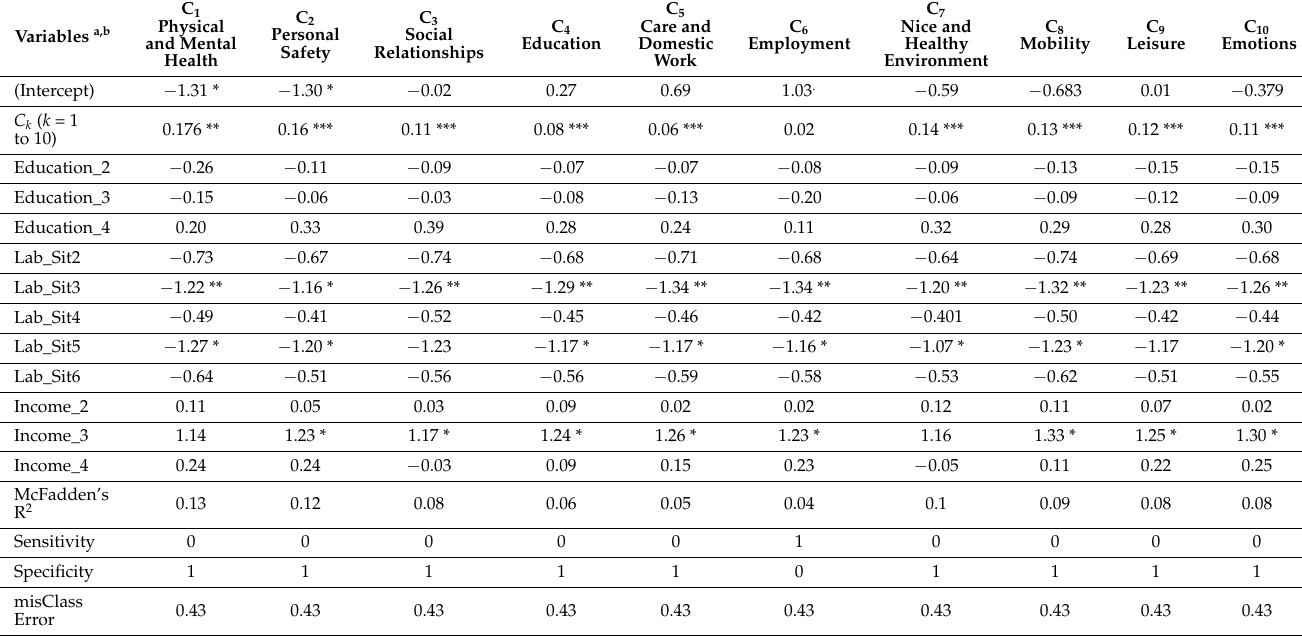
Table A1. Significance of coefficients of regressions with different capabilities.